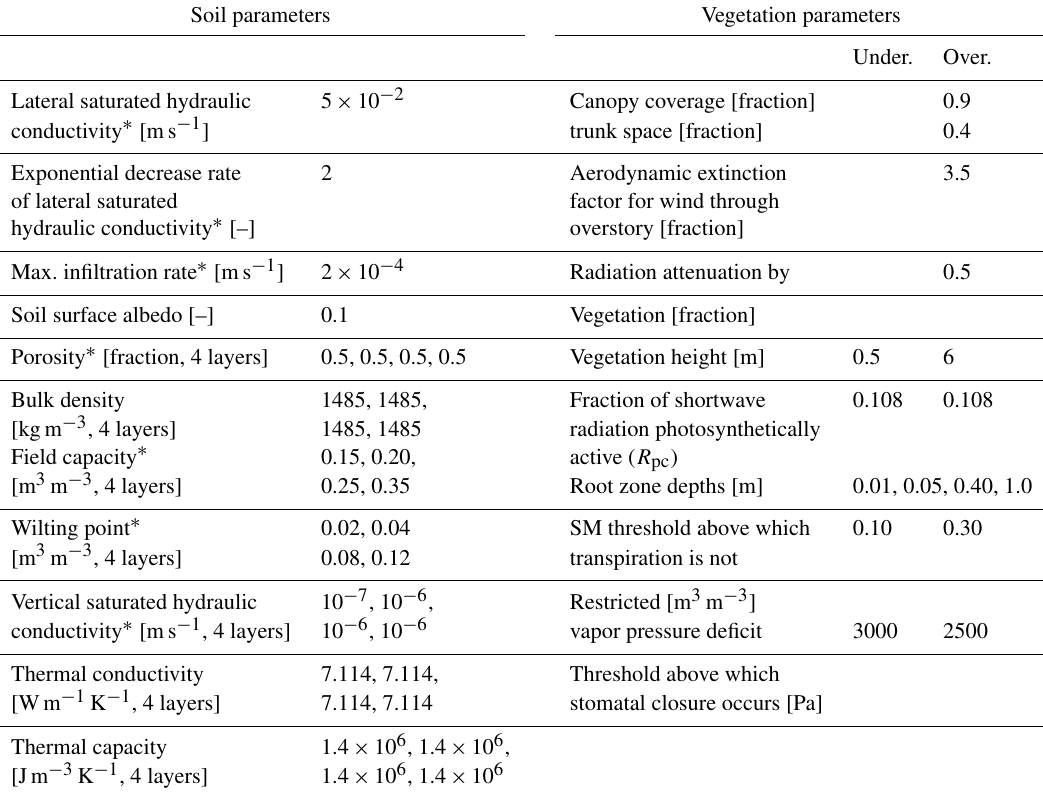
Table 1. DHSVM soil and vegetation parameter values (understory and overstory) after calibration. The marker ∗ indicates the parameters that have been re-estimated for the whole basin compared to Gascon et al. (2015). Soil parameters Vegetation parameters Under.